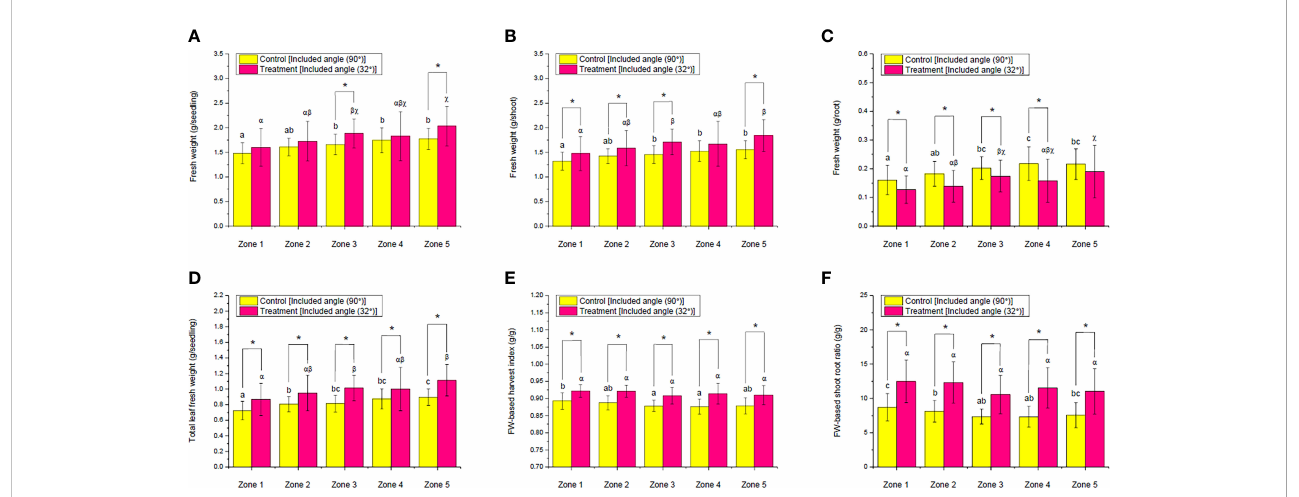
FIGURE 8 Comparison of the fresh weight (FW) of (A) seedling, (B) shoot, (C) root, and (D) total leaf as well as (E) FW-based harvest index and (F) FW-based shoot – root ratio of choy sum at seedling stage on day 16 grown in an indoor farm rack with and without the application of an adjustable lampshade-type re fl ector (ALR). The asterisk (*) indicates signi fi cant differences found between the control and treatment (Student ’ s t -test; p < 0.05), while different Greek alphabets ( a , b , and c ) and the lowercase letters (a, b, and c) indicate signi fi cant differences among all the zones with and without the application of ALR ( N zone1 = 45, N zone2 = 38, N zone3 = 32, N zone4 = 26, N zone5 = 19, one-way ANOVA; Tukey multiple-comparison; p <